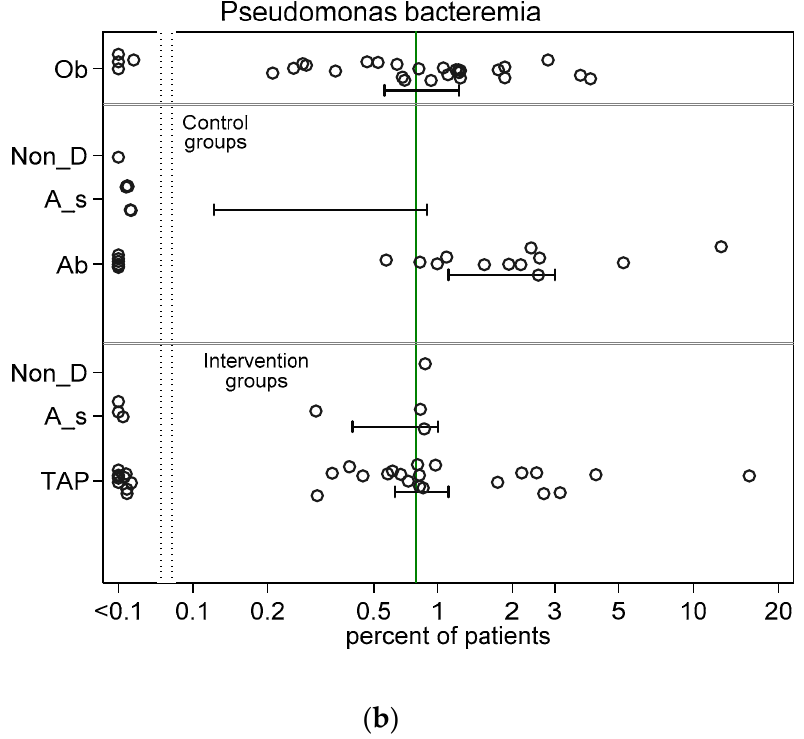
Figure 3. Scatter plots (logit scale) and 95% CI of Pseudomonas VAP incidence ( a ) and Pseudomonas bacteraemia ( b ) in component (control and intervention) groups of various methods of infection prevention in the ICU, excluding studies with ICU-LOS < 5 days (ESM Figure S3a,b show including studies with ICU-LOS < 5 days). The benchmark incidence in each plot is the summary mean derived from the observation studies (central vertical line). Abbreviations; Ob = observational; non-D is non-decontamination, A_s is anti-septic; Ab is antibiotic control group; TAP is topical antibiotic prophylaxis.